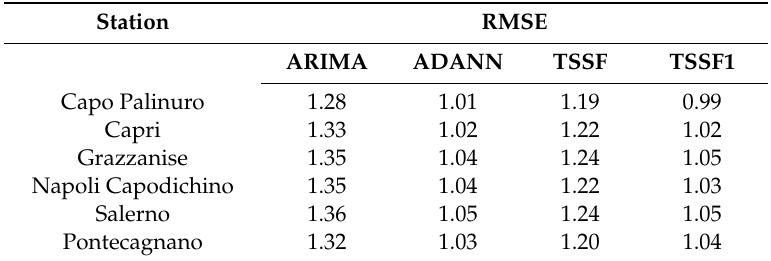
Table 3. RMSE of the test dataset for the HI index time series from all the weather station datasets obtained by using ARIMA, ADANN, TSSF, and